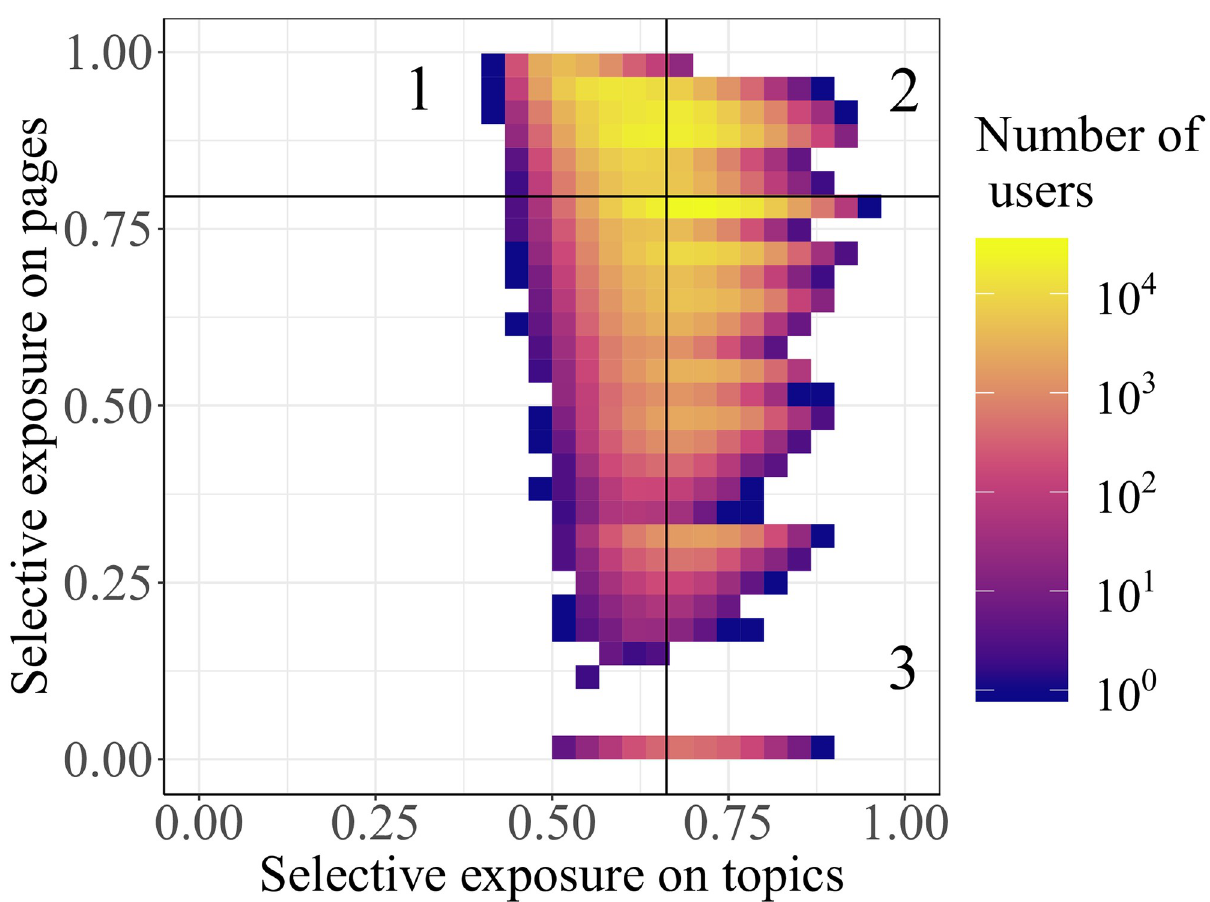
Fig 5. Interrelation between the mechanism of selective exposure to pages and topics. The area is divided in four regions determined by the average values of selective exposure to topics g † = 0.662 and topics g ⊳ = 0.796. The distributions of g † and g ⊳ are reported in Fig 6 of S1 File. Three out of four regions are labelled since they can be associated with different kind of selective exposure displayed by users. The region of multi-topic selective exposure is located in the top-left, the region of single-topic selective exposure is located in the top-right while the region of exposure by interest is located in the bottom left. The colour scale of the distribution represents the number of users related to a certain ( x , y )